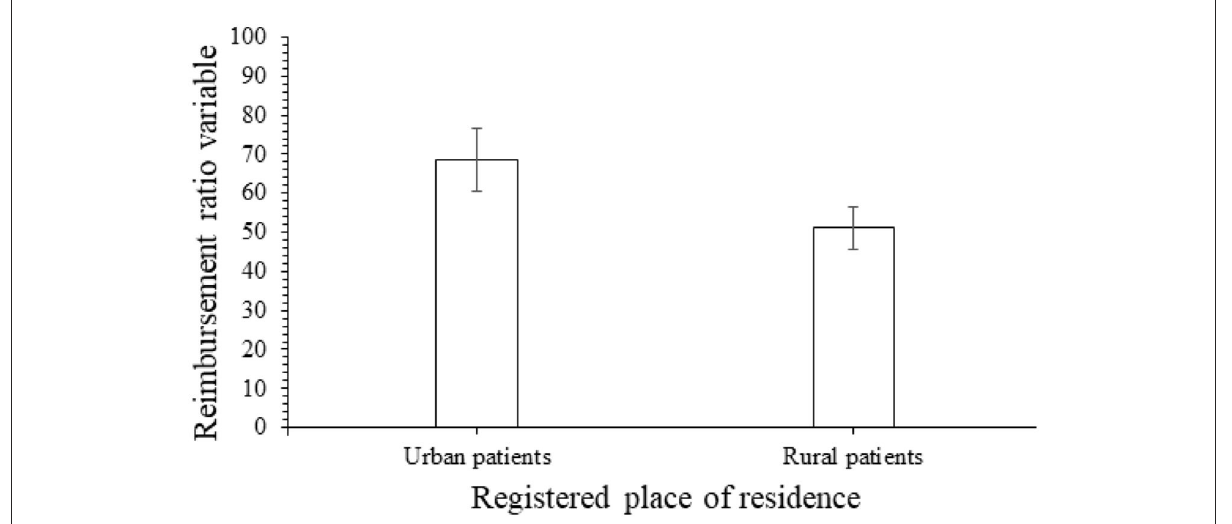
FIGURE2 The reimbursement ratio varies according to the registered place of